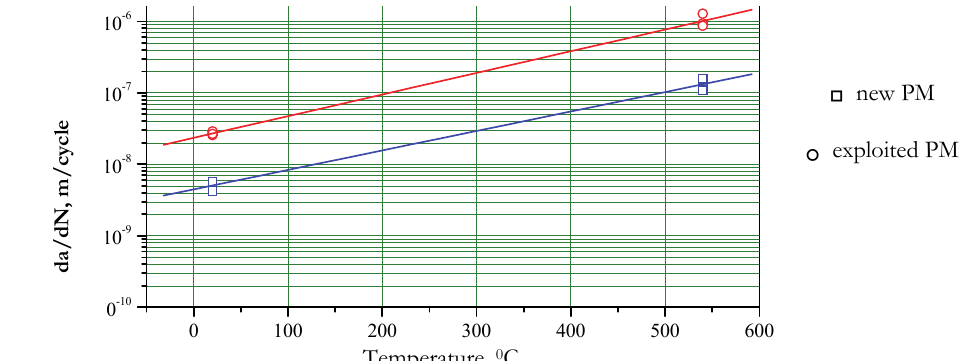
Figure 6: Fatigue crack growth rate, da/dN, vs. temperature for specimens with notches in PM.